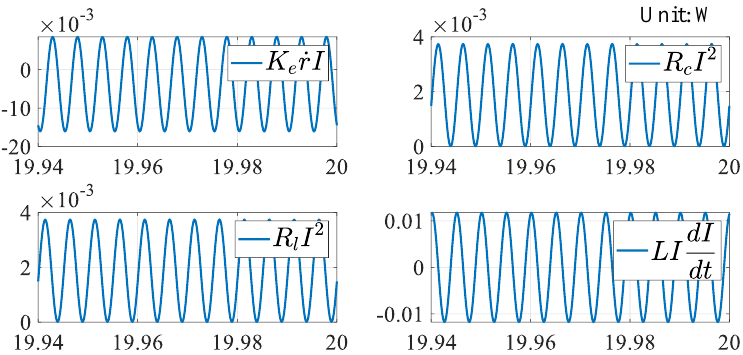
Figure 12. Electrical energy flow for